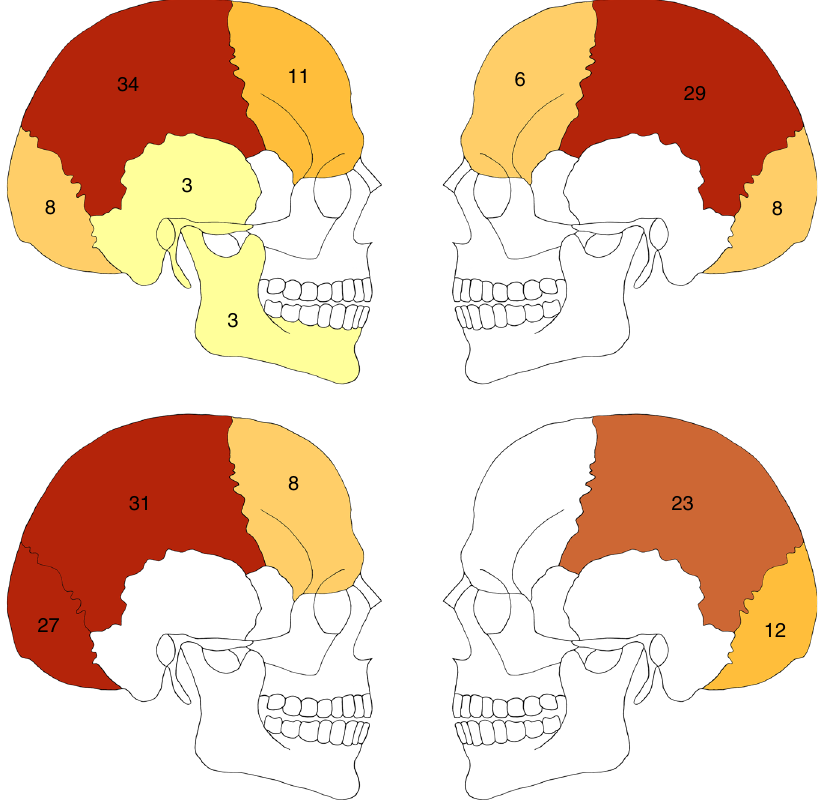
Fig. 8 Comparison of perimortem cranial trauma distributions in two LBK mass grave sites. Numbers and respective shading depict approximate percentages of overall blunt force cranial trauma identi fi ed at Talheim (top) and Halberstadt (bottom). Talheim data adapted from the literature